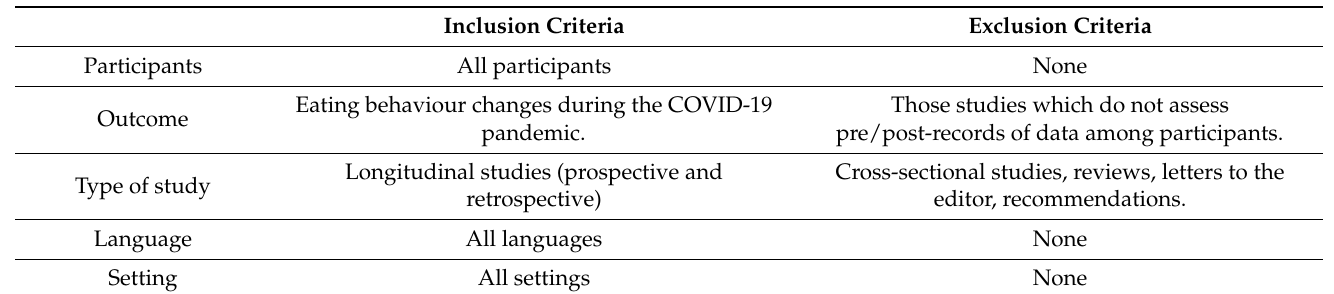
Table 1. Inclusion and Exclusion Criteria.